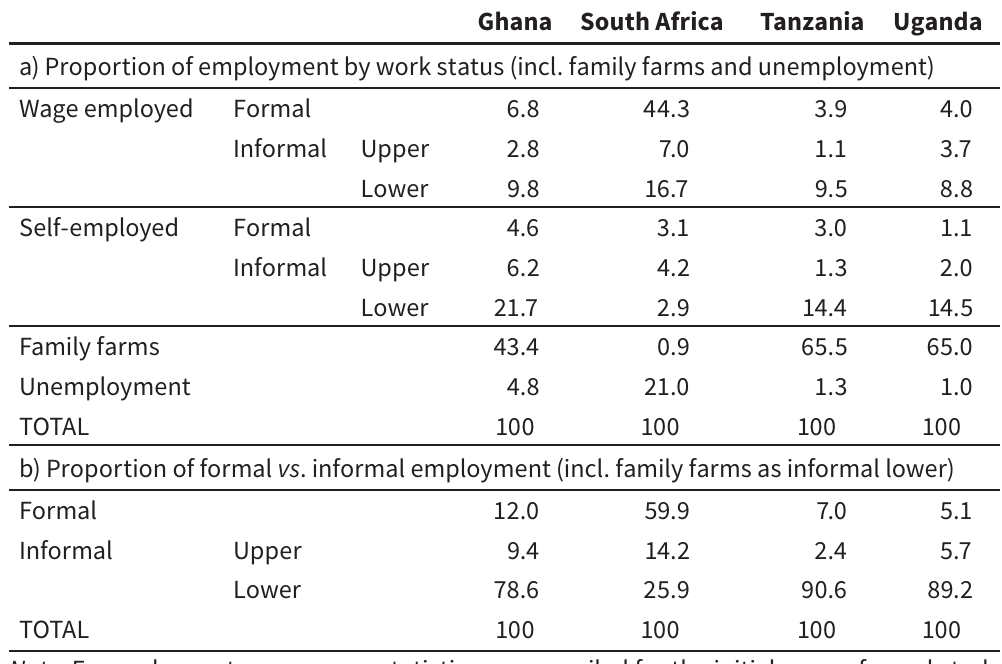
Distribution of workers by work status (%), extended definition